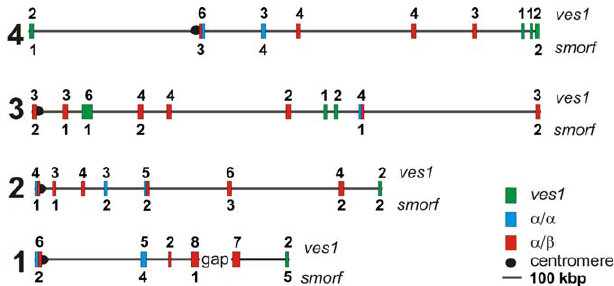
Figure 1. Representation of B. bovis Centromeres, ves1 , and smorf Genes Each chromosome is represented by a black line, with the chromosome number shown on the left. Centromeres are depicted as black dots. ves1 loci are depicted as colored boxes, and the number of ves1 and smorf genes in each locus is shown above or below the colored boxes, respectively. Red and blue boxes indicate the presence of at least one ves1 a / ves1 b or ves1 a / ves1 a pair, respectively, within the